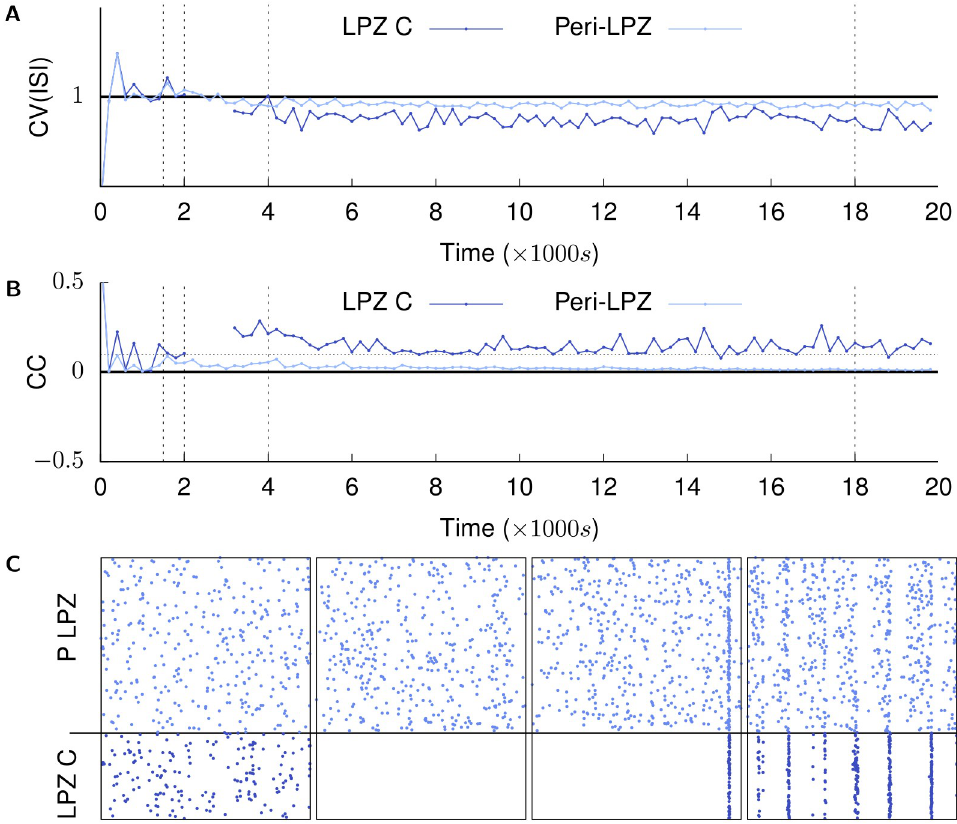
Fig 4. Recovery of activity over time: population firing characteristics. (A) shows the coefficient of variation ( CV ) of the inter-spike intervals of neurons in the LPZ-C and peri-LPZ. (B) shows the average pairwise cross-correlation between neurons in the LPZ-C and peri-LPZ calculated over 5 ms bins [43]. (dotted horizontal line is y = 0.1); (C) shows spike times of neurons in the LPZ C and peri-LPZ over a 1 s period at t = {1500 s, 2001.5 s, 4000 s, 18,000 s}. The network is permitted to achieve its balanced Asynchronous Irregular (AI) low frequency firing regime under the action of inhibitory synaptic plasticity ( t � 1500 s). At ( t = 2000 s), neurons in the LPZ are deafferented (panel 2 in B is at t = 2001.5 s) and the network allowed to repair itself under the action of our structural plasticity mechanism (panels 3 ( t = 4000 s) and 4 ( t = 18,000 s) in B). As can be seen here, the network does not return to its AI state after repair (graphs are discontinuous because ISI CV and CC are undefined in the absence of